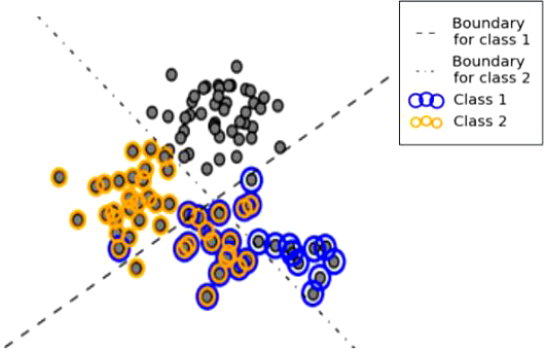
Fig. 6. Multi-class classi¯cation results.